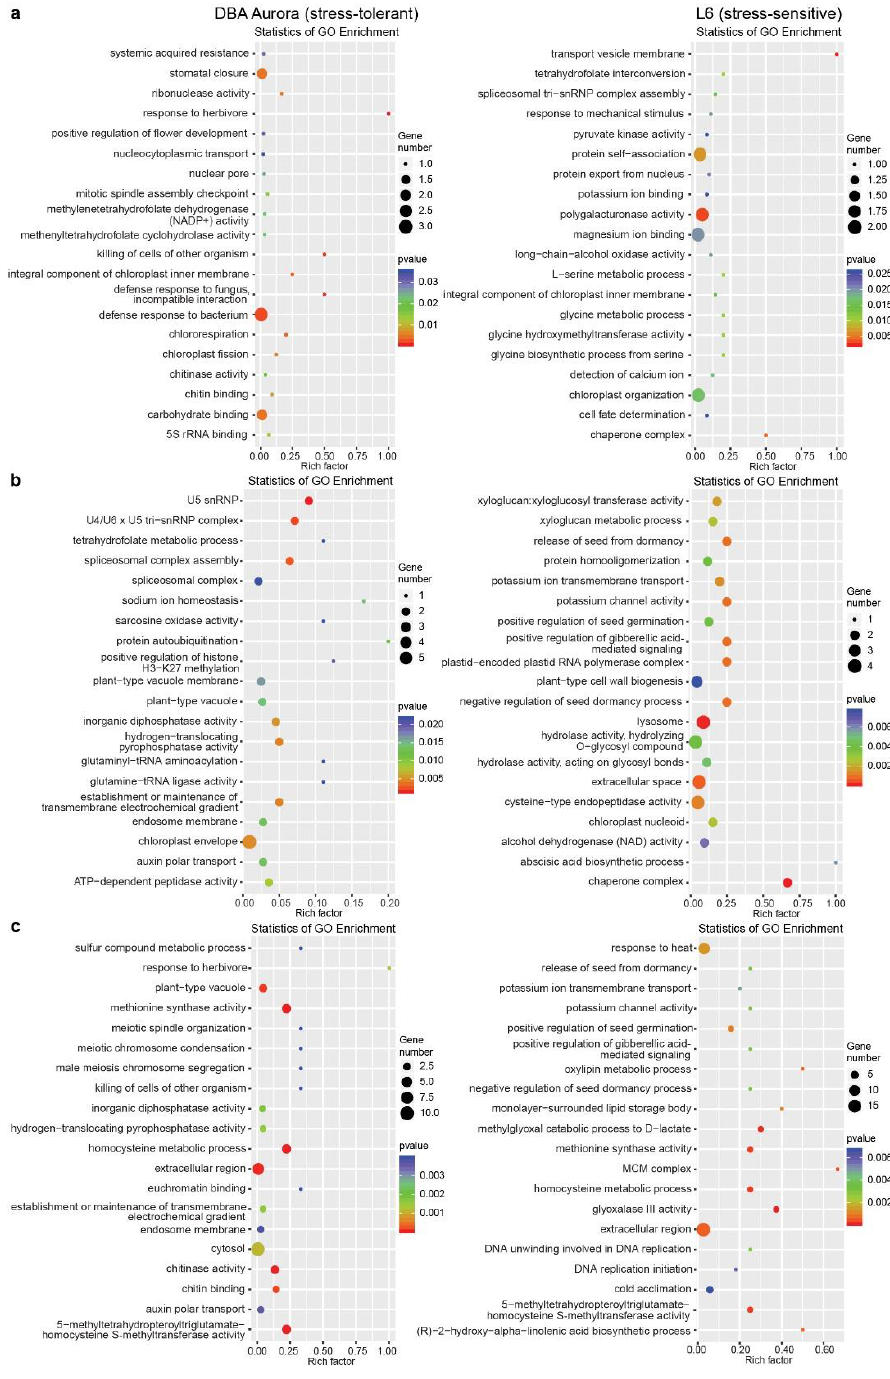
Figure 4. GO enrichment analysis of stress-responsive miRNA–mRNA pairs with significant ( p < 0.05) antagonistic expression patterns subject to each stress type. ( a ) GO analysis of miRNA–mRNA pairs responsive to water deficit stress. ( b ) GO analysis of miRNA–mRNA pairs responsive to heat stress. ( c ) GO analysis of miRNA–mRNA pairs responsive to water deficit plus heat stress. The rich factor represents the proportion of stress-responsive genes within all the genes under a certain GO term (a higher rich factor indicates higher level of enrichment).